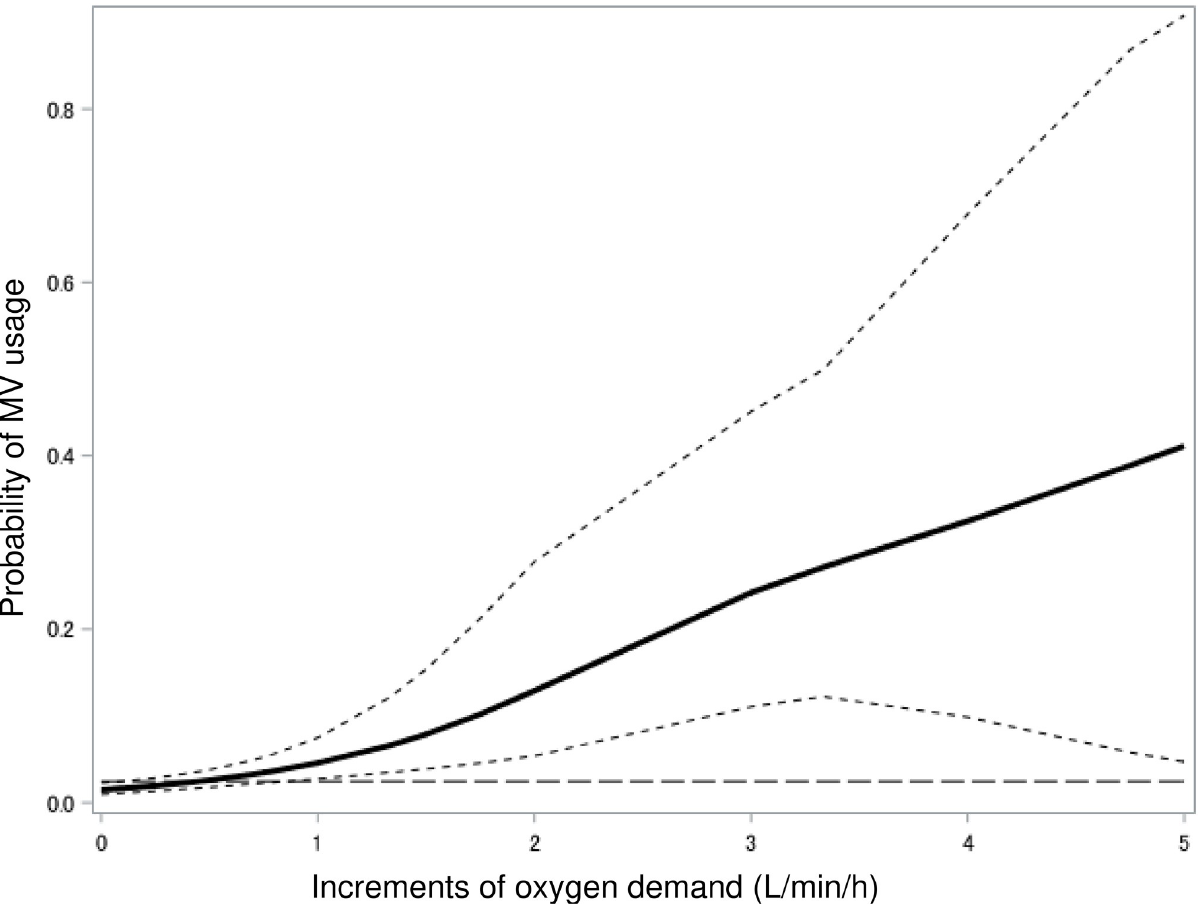
Fig 3. Restricted cubic spline curves and threshold of increments in oxygen demand. The restricted cubic spline curve was shown for the risks of MV use within 12 h by increments in oxygen demand, with dashed lines for 95% CI. Based on the inflection point, which considers an increase of absolute risk from the baseline by > 1% (horizontal dashed line), 0.44 L/min/h of increment in oxygen demand was identified as the threshold to predict mechanical ventilation in the next 12 h. With a higher increment of oxygen than the threshold, the probability of MV use linearly increased. Abbreviations: MV, mechanical ventilation; CI, confidence